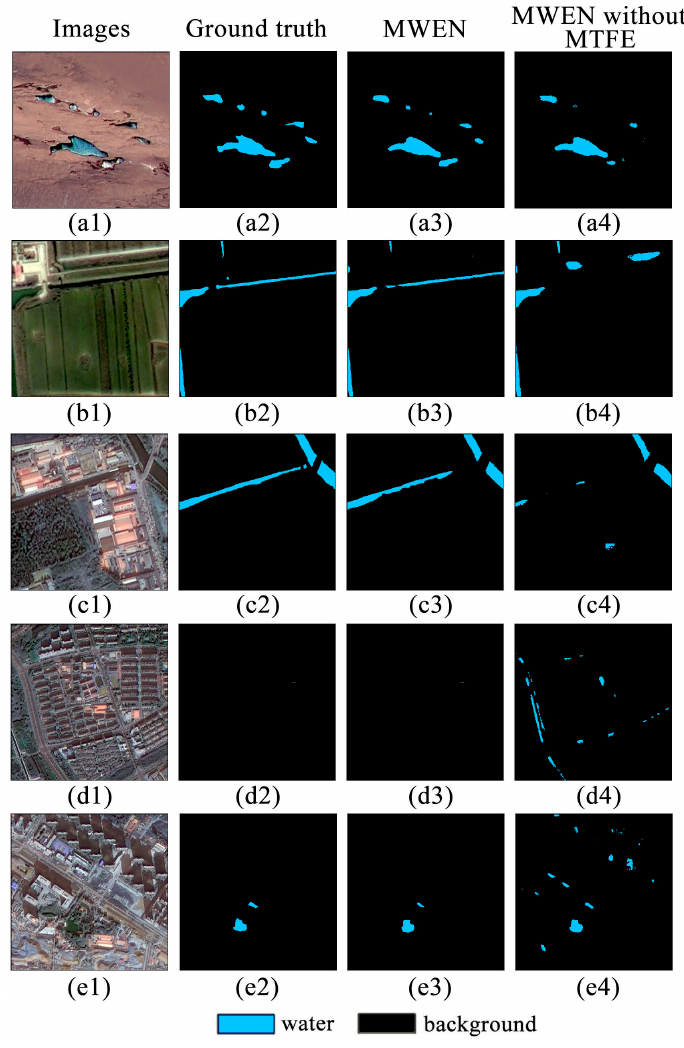
Figure 9. Results comparison between MWEN “with MTFE” and “without MTFE”. (a1–e1) are the images, (a2–e2) are the ground truth, (a3–e3) are the water maps extracted by the MWEN “with MTFE”, (a4–e4) are the water maps extracted by the MWEN “without MTFE”.